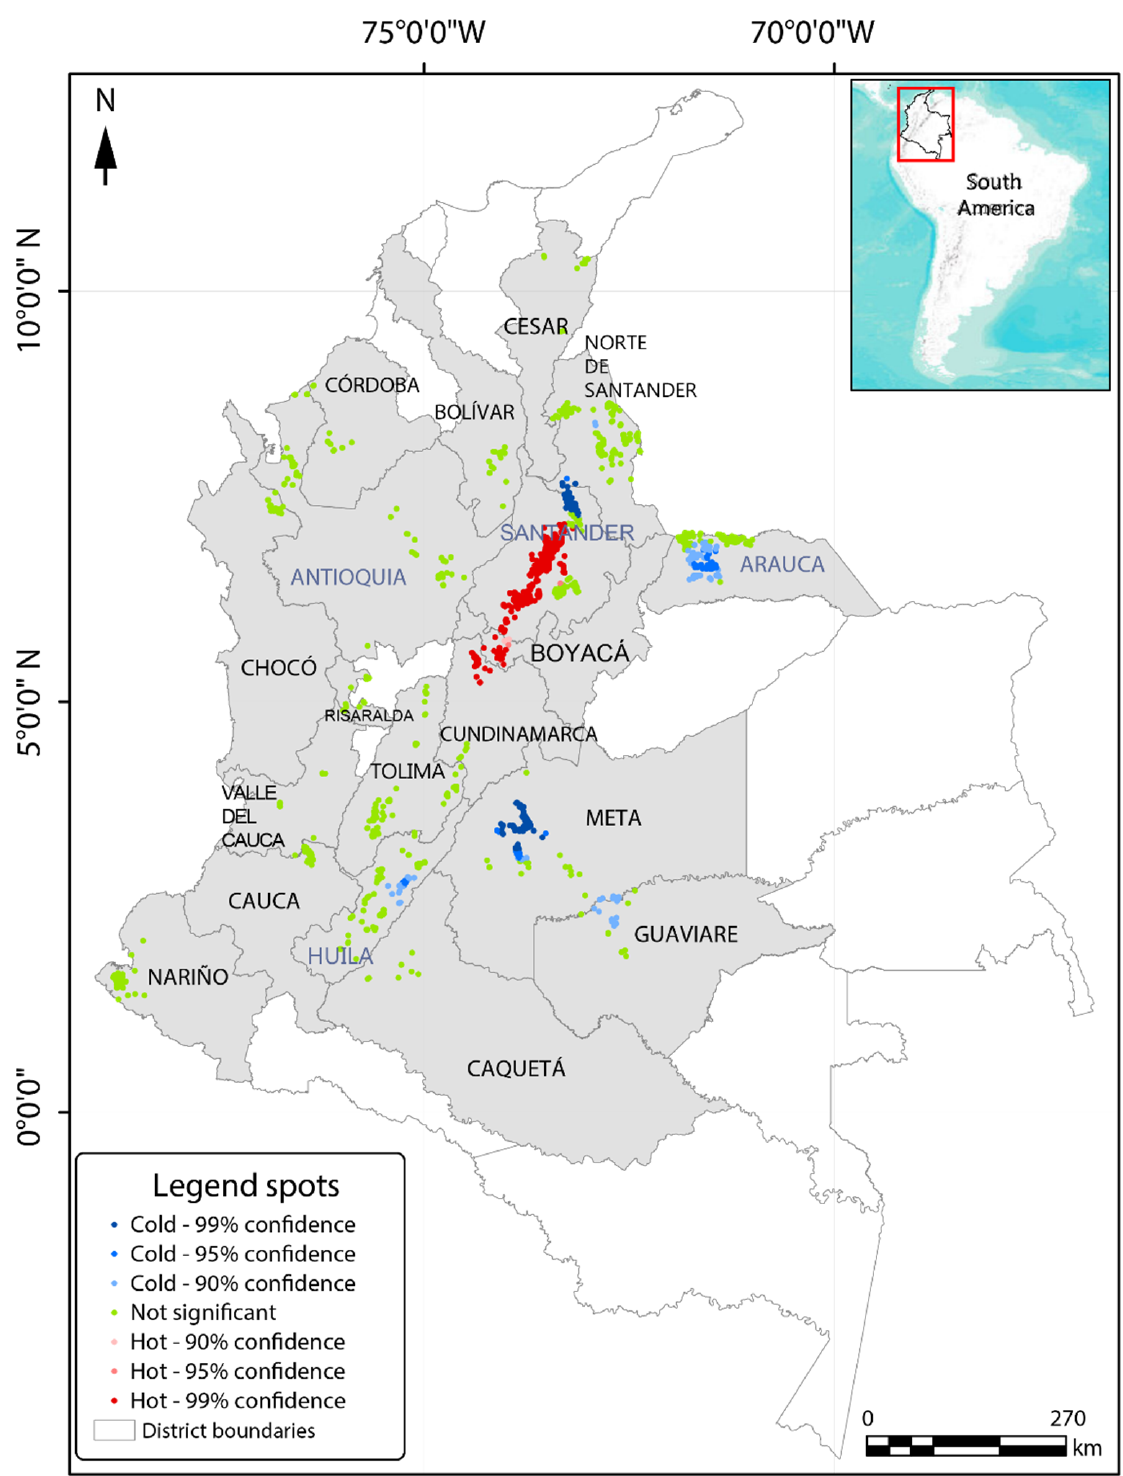
Figure 3. Analysis of hotspots (red dots) and coldspots (blue dots) of the studied area.